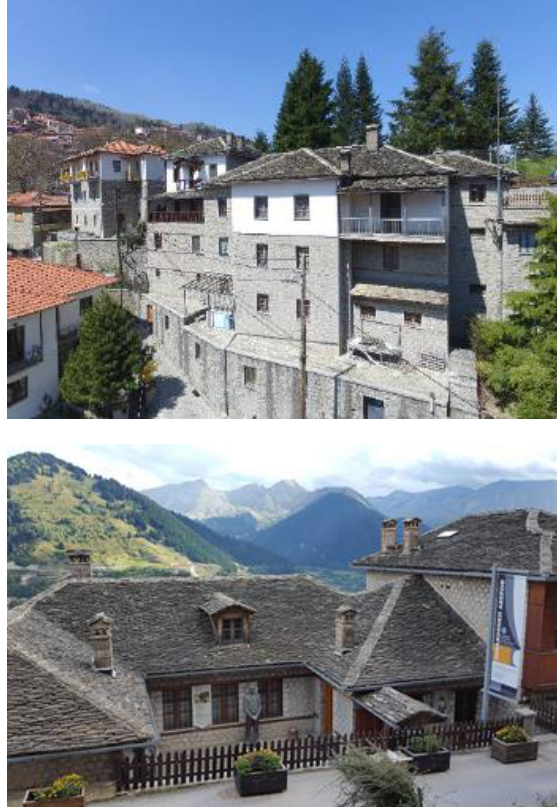
Figure 2: Averof’s Museum of Neohellenic art in Metsovo, Greece.